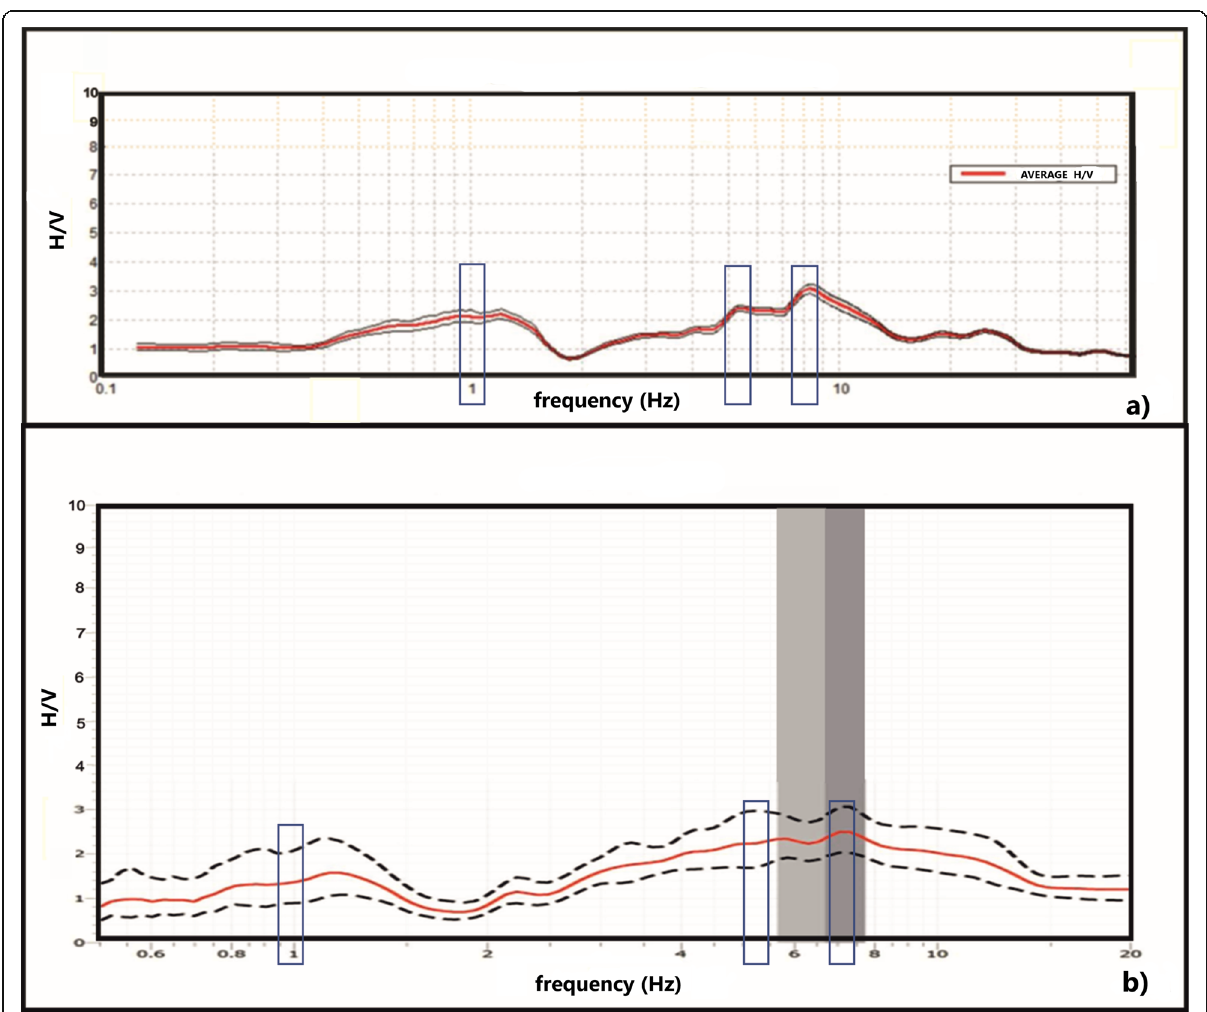
Fig. 9 Noise measurements at Villa Sant ’ Angelo center by a the Tromino device; b the DAQLink